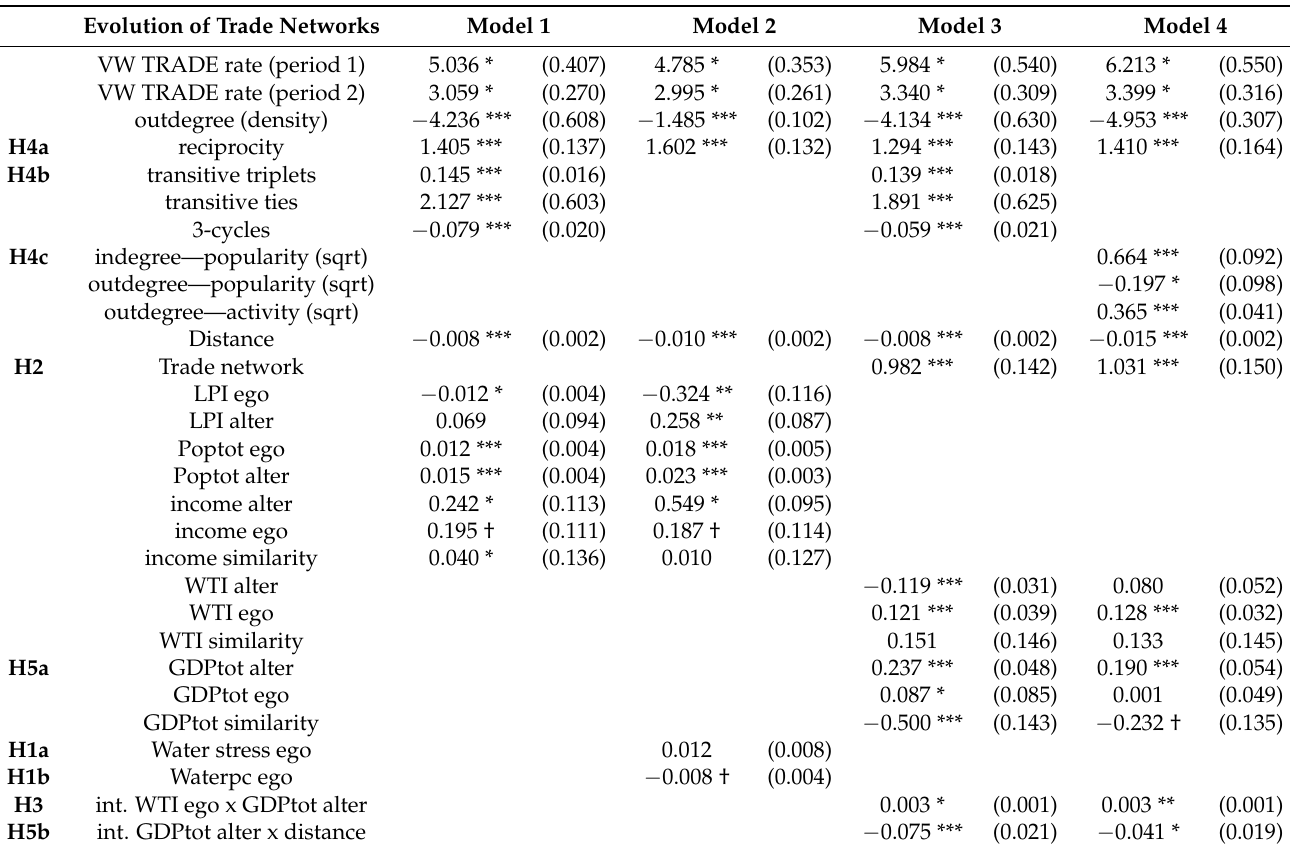
Table 3. Estimated results of global VWT network